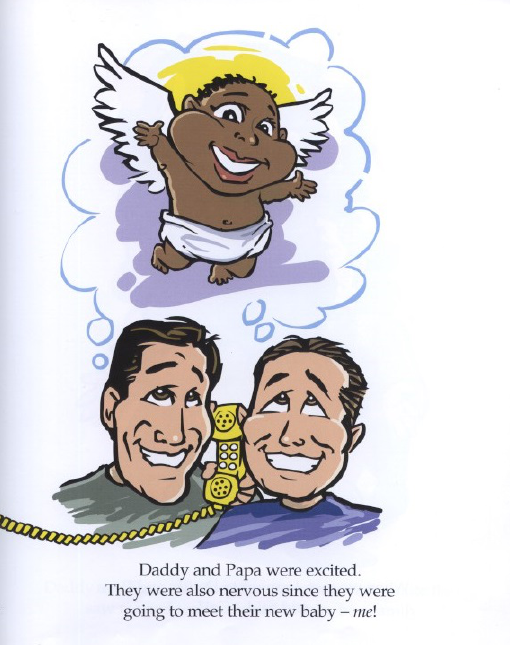
Figure 4. The child as a trope of innocence and futurity.